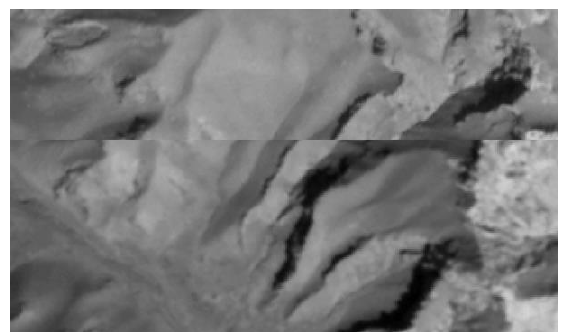
Figure 10. The accuracy of plane edge connection exceeds the